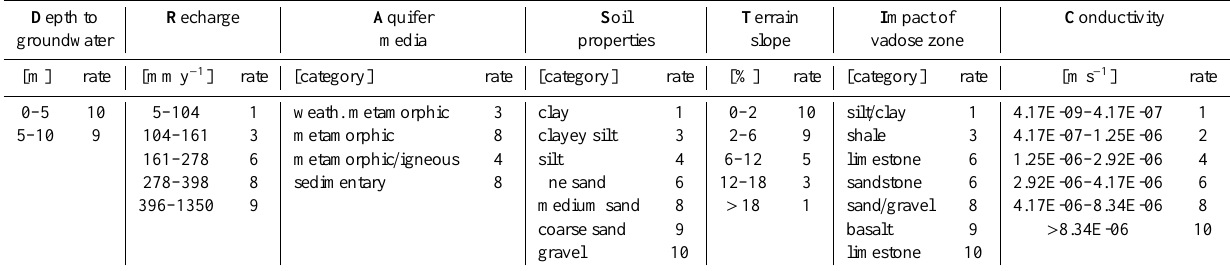
Table 5. Combined parameters and weights for DRASTIC modelling.